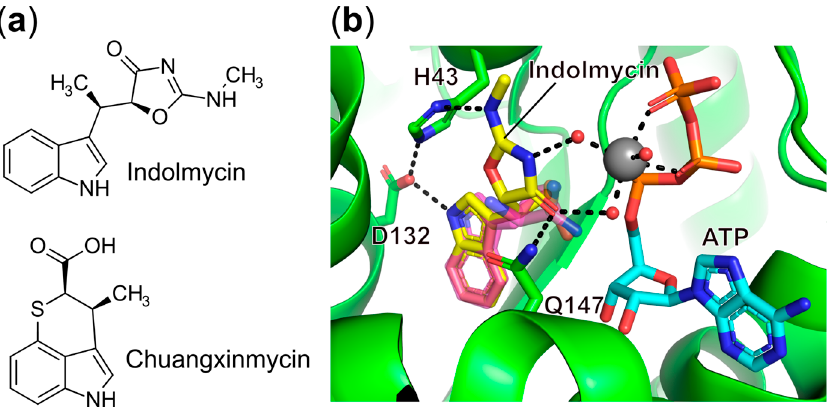
Figure 3. Structures of inhibitors targeting TrpRS. ( a ) Chemical structures of TrpRS inhibitors; ( b ) Superposition of the ternary structures of B. stearothermophilus TrpRS in complex with indolmycin and ATP (PDB entry: 5DK4) and B. stearothermophilus TrpRS in complex with ATP and trypto- phanamide (PDB entry: 1MAU). The backbone of the former structure is shown as a cartoon repre- sentation (green) while ligands and interacting protein side-chains are shown as sticks. For clarity, ATP and a Mg 2+ ion (grey sphere) and coordinated water molecules (red spheres) are shown for only one structure. The C-atoms of indolmycin and tryptophanamide are colored in yellow and salmon, respectively. H-bond interactions are shown as black dashed lines.